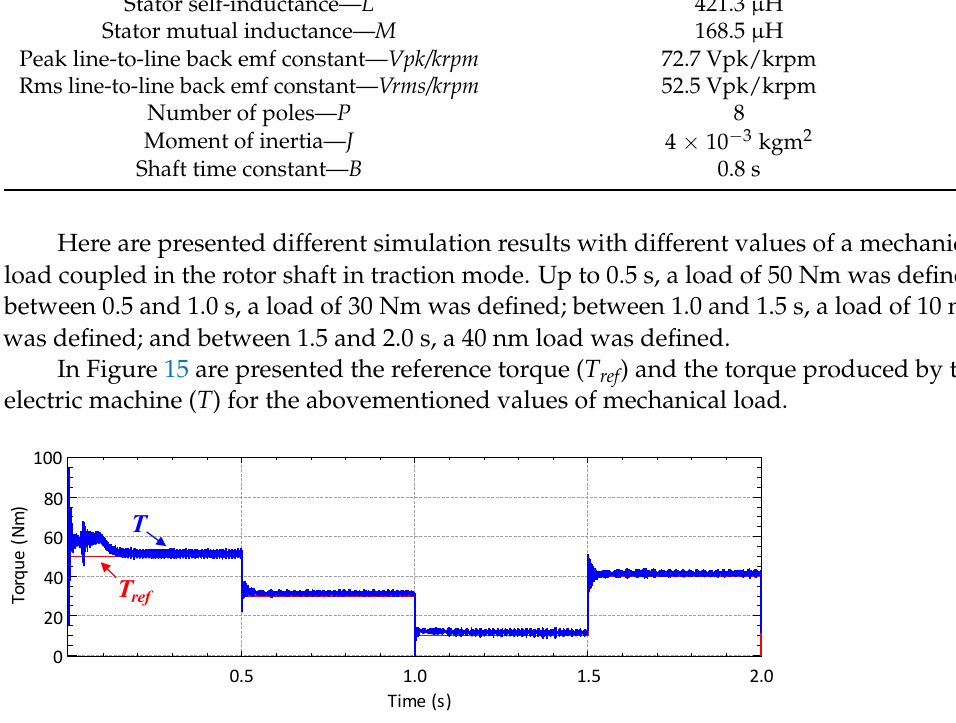
Figure 15. Simulation results of the reference torque and the torque produced by the electric machine for different mechanical loads.